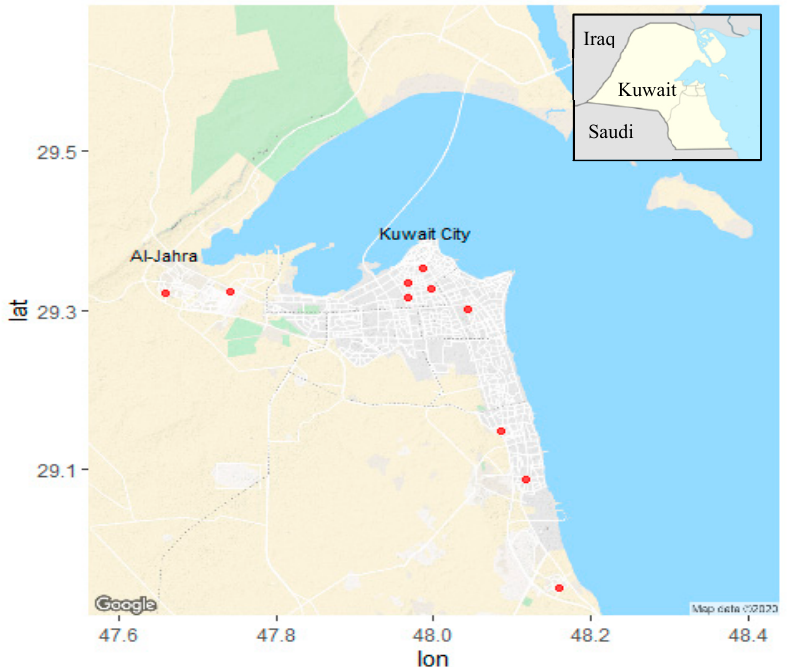
Figure 1. Geographical distribution of sampled residencies in Kuwait as illustrated by red dots, plotted using ggmap [27].